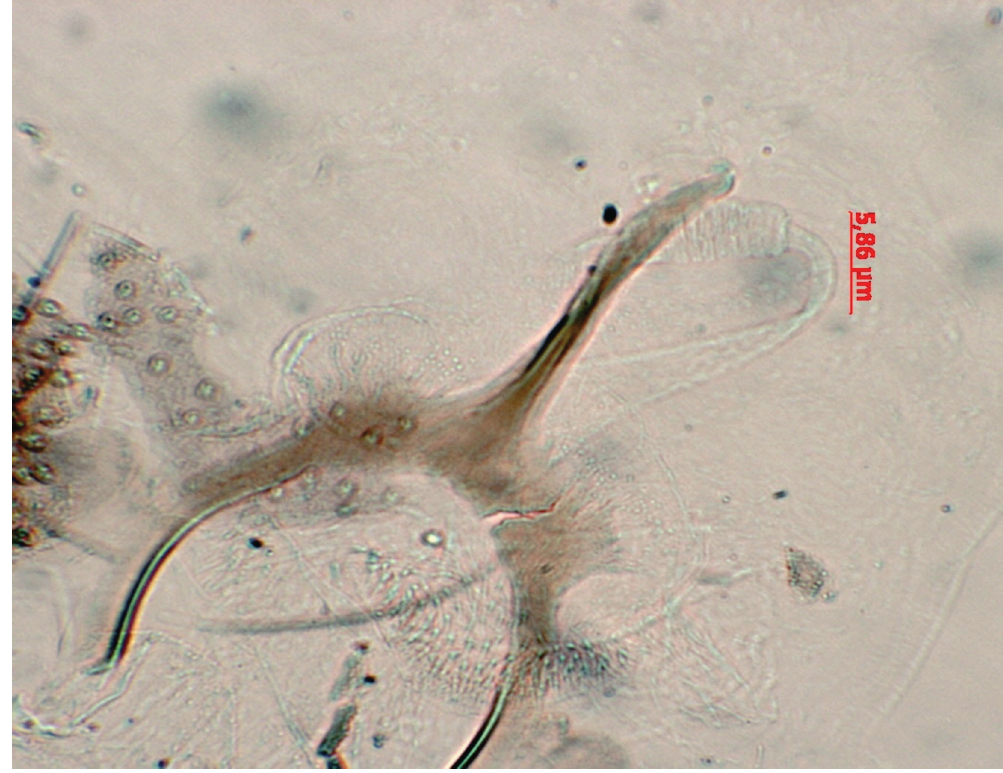
Fig. 2. – Spermathecae of Phlebotomus (Larroussius) chadlii (photonic microscope ×